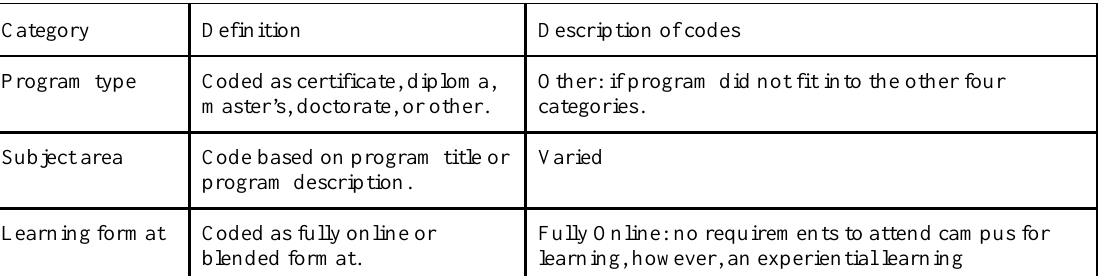
Codebook Used to Deductively Code